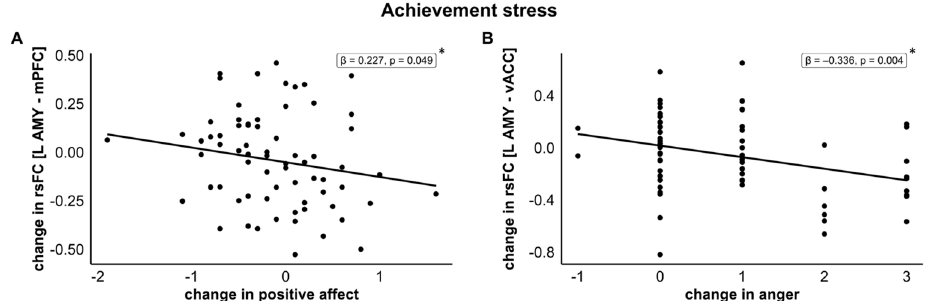
Figure 5. ( A ) Association between changes in rsFC of the amygdala and the mPFC and changes in the positive affect from pre- to post-achievement stress, and ( B ) association between changes in rsFC of the amygdala and the vACC and changes in anger from pre- to post-achievement stress. Change values from before to after social exclusion or achievement stress, respectively. * Indicates significance of p < 0.05. Abbreviations: vACC = ventral anterior cingulate cortex; AMY = amygdala; mPFC = medial prefrontal cortex.